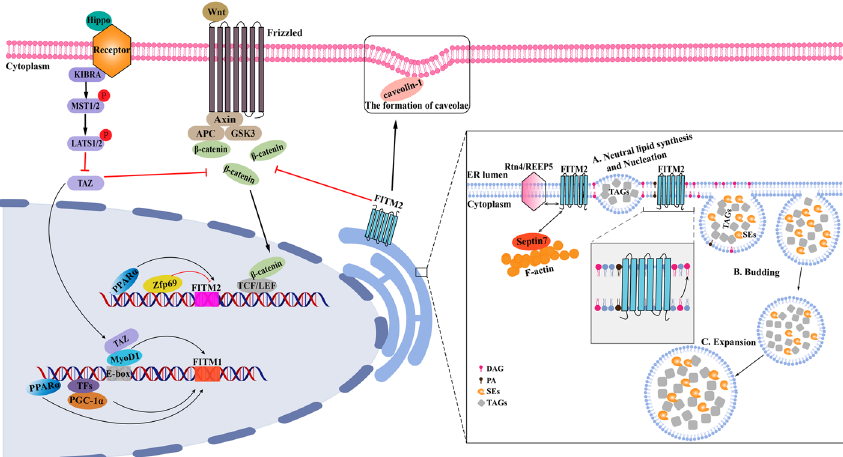
Fig. 2 Schematic model of FITM expression regulation and their functions primarily in the formation and budding of LDs (modified mainly according to references [6, 20, 30, 47]). The expression of FITM1 can be upregulated by MyoD1, PPARα, and PGC-1α, while MyoD1 is activated by the Hippo signaling pathway. The expression of FITM2 is increased by PPARα, and decreased by Zfp69. The overexpression of FITM2 leads to the inhibition of the Wnt/β-catenin pathway and stimulates caveolae formation by regulating the expression of caveolin-1. The process of de novo LD biosynthesis is divided into three major steps: A Neutral lipid synthesis and nucleation; B Budding; C Expansion. During this process, FITM2 might help to concentrate TAG between the leaflets of the endoplasmic reticulum, and then promote the formation of an oil lens structure, which is the characteristic of the nucleation step. In addition, FITM2 maybe participate in reducing the DAG level in the cytoplasmic leaflets, and then facilitate the budding of lipid droplets. Furthermore, FITM2 could bind to cytoskeletal protein Septin7 and interact with ER tubule-forming proteins Rtn4 and REEP5 during nascent LD formation. PGC-1α peroxisome proliferator-activated receptor-gamma coactivator 1 alpha, PPARα peroxisome proliferator activated receptor alpha, MyoD1 myogenic differentiation 1, TAGs triacylglycerols, DAGs diacylglycerols, SEs sterol esters, PA phosphatidic